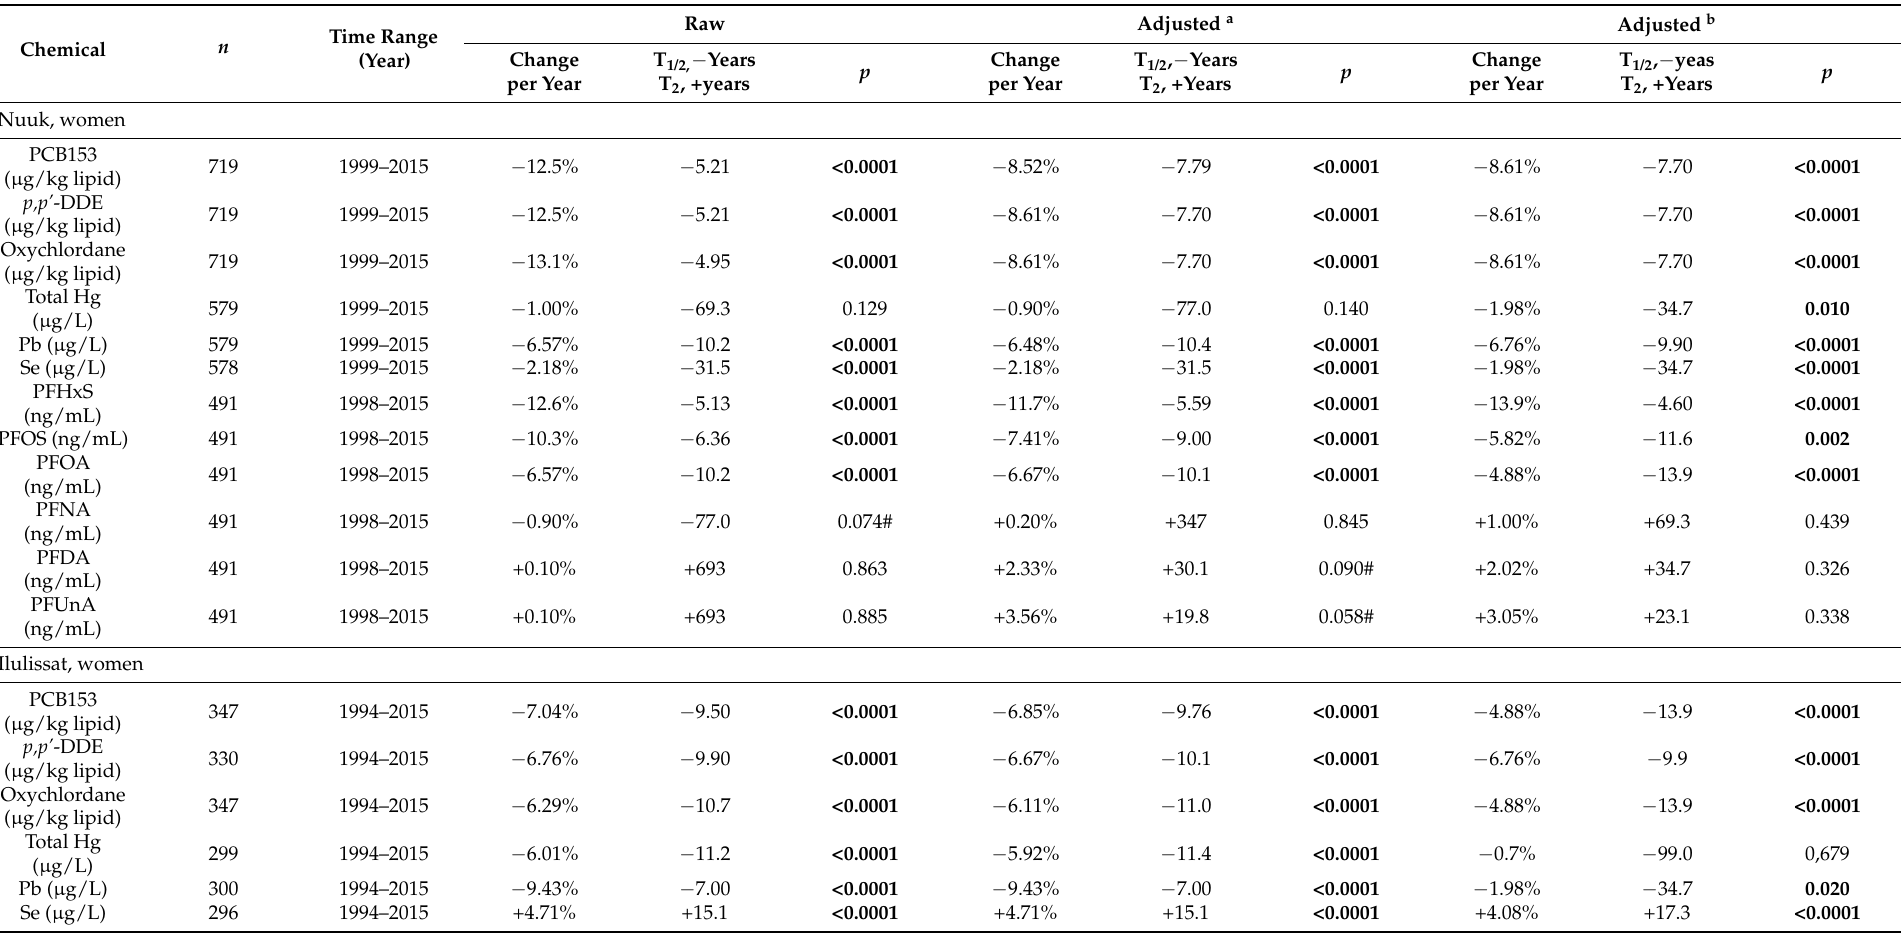
Table 7. Women in Nuuk and Ilulissat: Changes in the levels of lipPOPs, metals and PFASs, given as the time to halve the concentration (T 1/2 ) or the time to double the concentration (T 2